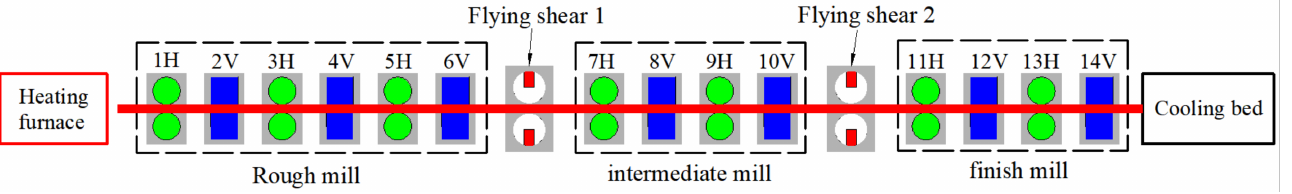
Figure 4. Layout of Φ 25 mm clad rebar rolling line.